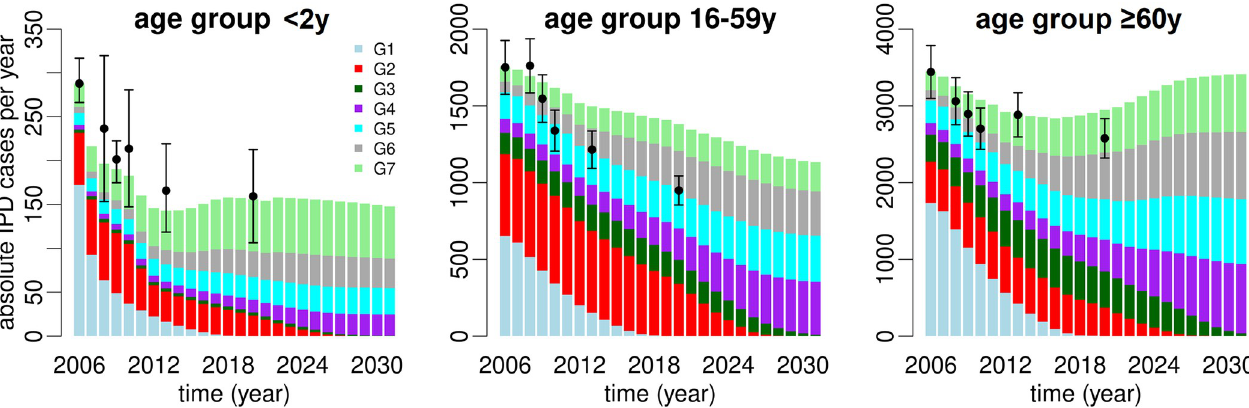
Fig 6. Stacked bar plots of predicted absolute IPD cases per year from 2006 to 2031 in Germany for three different age groups ( < 2y, 16-59y, � 60y). The stacked bars illustrate the serotype groups defined in Table 1: PCV7 ( G 1; light blue), PCV13 non-PCV7–3 +6C ( G 2; red), serotype 3 only ( G 3; dark green), PCV15 non-PCV13 ( G 4; purple), PCV20 non-PCV15 ( G 5; cyan), PPSV23 non-PCV20 ( G 6; gray), Other serotypes ( G 7; light green). Heights of the individual bars correspond to the average model prediction without considering sensitivity of the model parameters (i.e., prediction intervals). Data points (reported IPD case numbers in Germany multiplied by an estimated year-specific underreporting factor) are shown as filled circles with 95% CIs. Age group 16-59y combines two (16-44y, 45-59y) and age group � 60y combines three (60-74y, 75-84y, � 85y) age groups of the model.